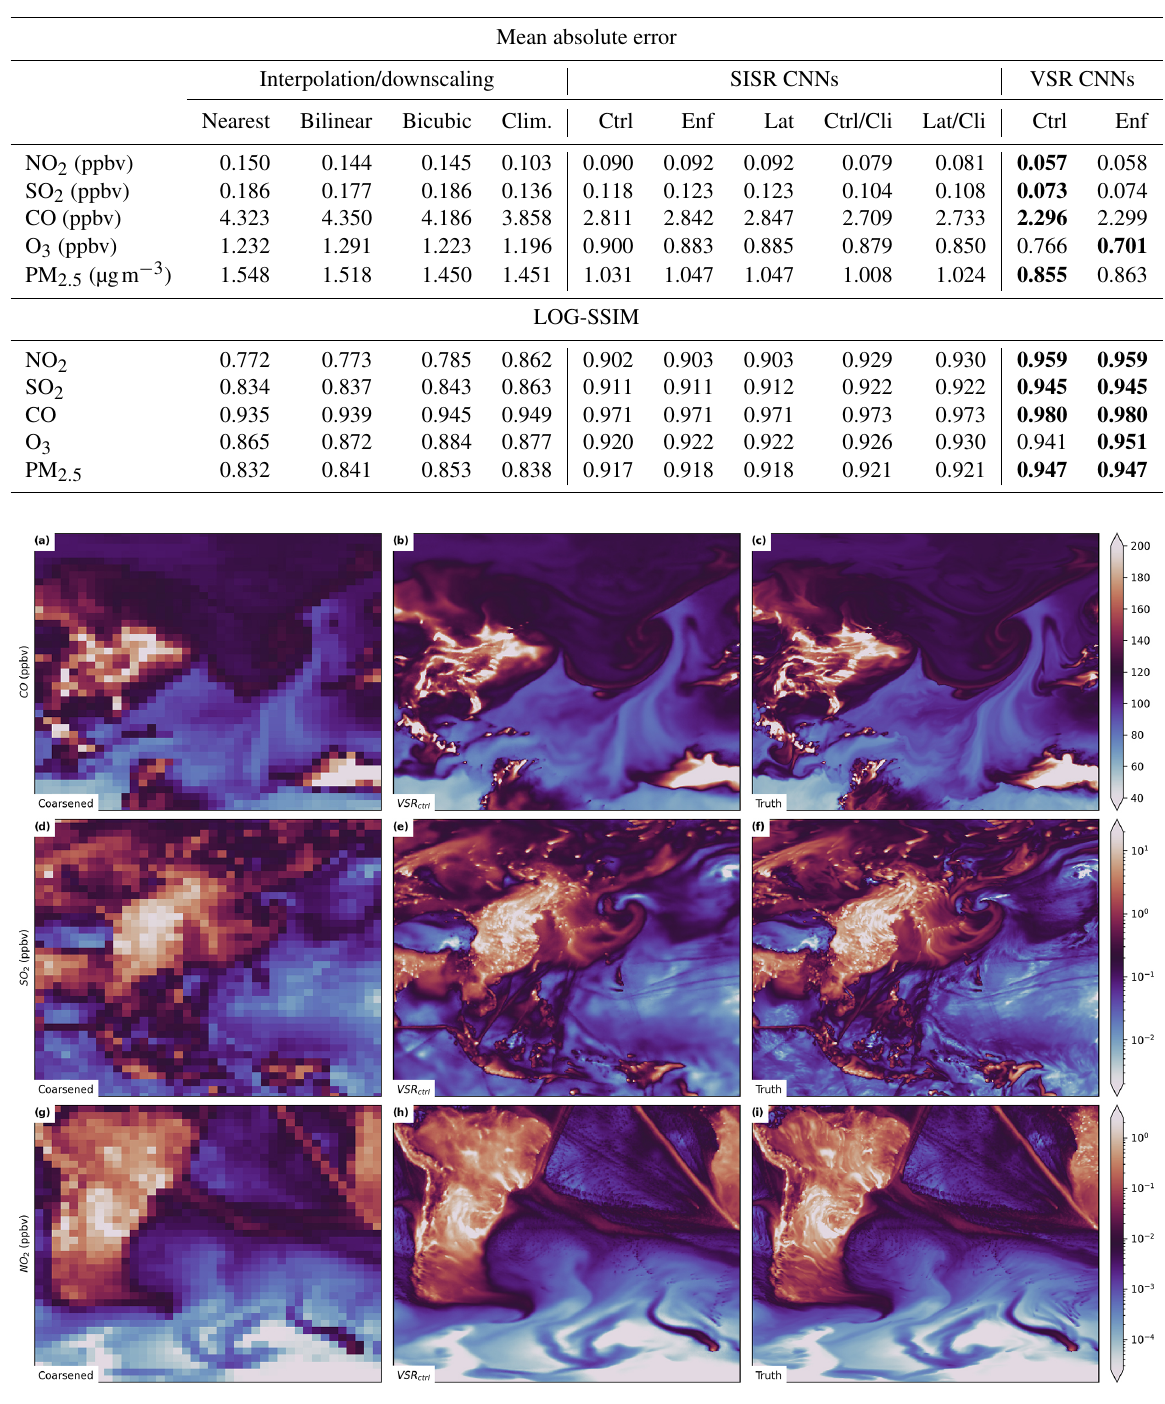
Table 1. Performance of the downscaling CNNs compared to interpolation and conventional downscaling. The top section shows pixel-level mean absolute error (lower values are better), and the bottom section shows the structural similarity index computed after taking the log of the lognormally distributed variables and scaling the data to a 0–1 range (higher values are better). The best-performing CNNs for each compound and error metric are indicated by bold text.